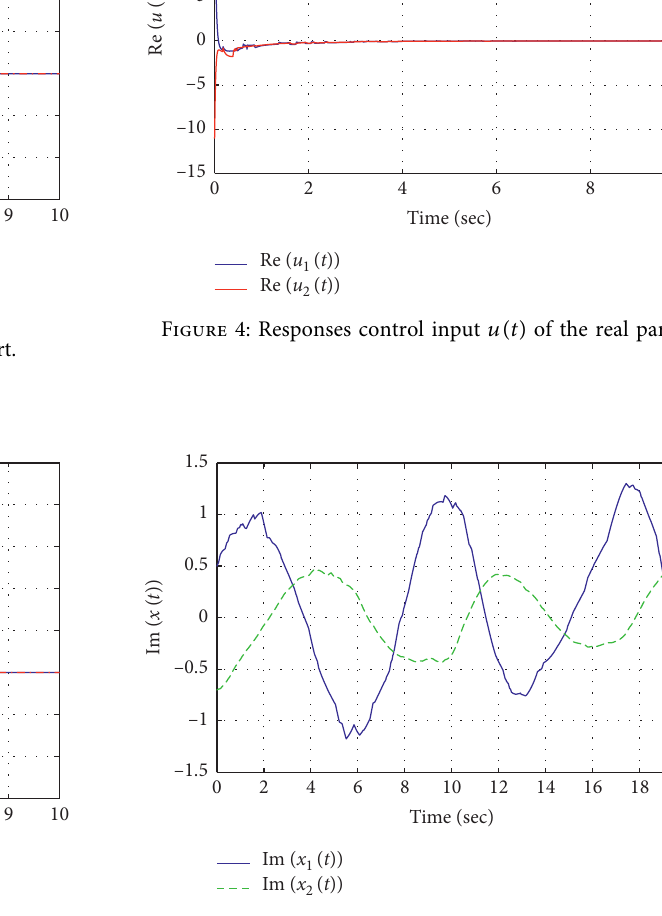
Figure 2: Responses the state of the real part.